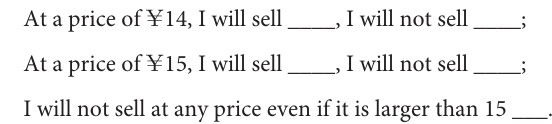
Frontiers in Behavioral Neuroscience |